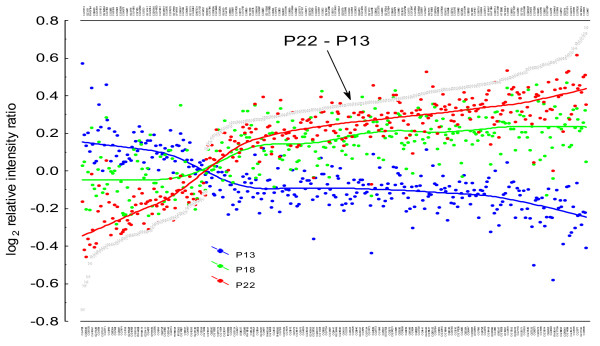
Transcriptome changes following thermal adaptation. Scatterplots of the average log2 relative intensity ratio for the 306 'differentially expressed genes' detected from the linear contrasts between the two furthest apart thermal selection regimes (i.e., 13°C vs. 22°C) and sorted according to the difference between warm- and cold-adapted (i.e., P22 – P13) populations. The sorted CG names of genes are given at the bottom (1, 3, 5, ⋯) and top (2, 4, 6, ⋯) axes. For each gene, the points in blue (P13), green (P18) and red (P22) give the average log2 relative intensity ratio for the different thermal regimes. The corresponding points have been connected by polynomial fitting to enhance visibility.